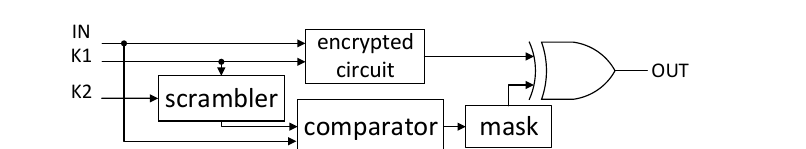
Figure 10: A hybrid obfuscation scheme consists of a SAT Hard (SH) obfuscation (SARLock) and a High Corruption (HC) Logic Locking